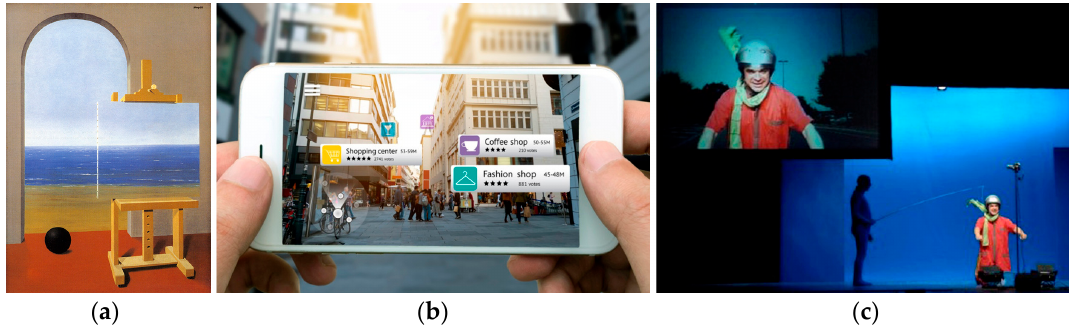
Figure 4. Some examples of images that duplicate other images accenting their original meanings. ( a ) René Magritte, La condition humaine , Geneve, Simon Spierer Collection, 1935; ( b ) Example of augmented reality app for mobile phone; ( c ) Giorgio Barberio Corsetti, Tra la terra e il cielo , Teatro Sangiorgi, Catania, 2008 (Fattore K and Teatro Massimo Bellini,